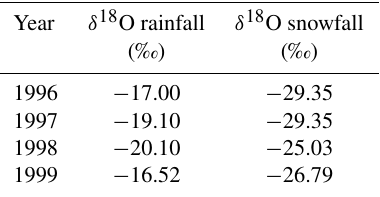
Table 3. Static δ 18 O ppt input compositions of annual rainfall and snowfall oxygen-18 for